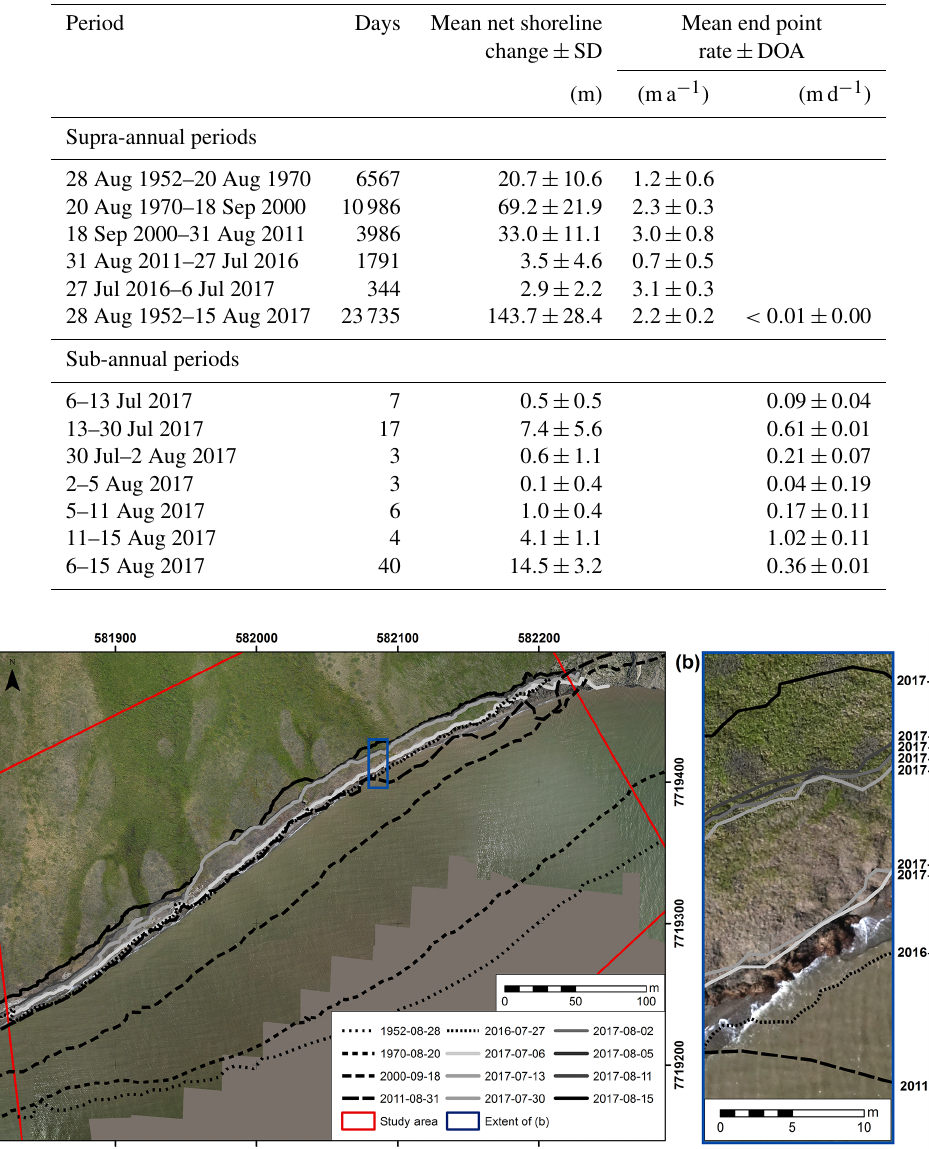
Figure 2. (a) Overview of the 500 m study area, illustrating all 12 shoreline positions since 1952 overlaid on the 6 July 2017 orthomosaic. (b) A 10-fold magnification in scale, illustrating the episodic nature of the shoreline changes at this location within the area of the blue bounding box depicted in (a)